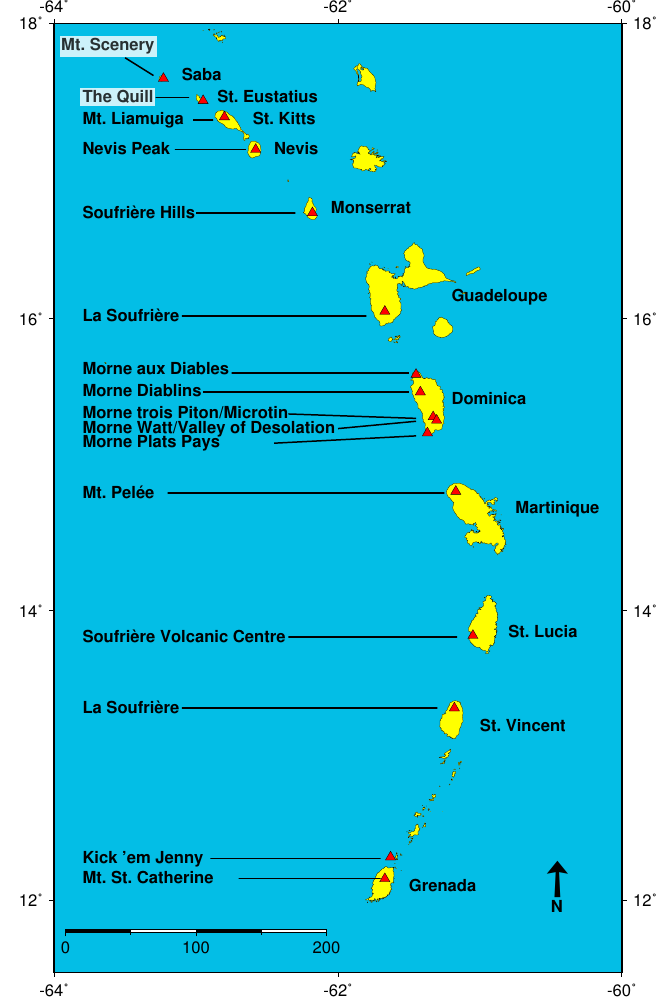
Figure 1. The active arc of the Lesser Antilles showing the islands of Saba and St. Eustatius in the far north, as well as the other islands of the chain. The red triangles depict the location of an active volcano, and their names shown on the left. Mt. Scenery and The Quill are highlighted. Both islands host a stratovolcano: Mt. Scenery (887 m elevation) at Saba and The